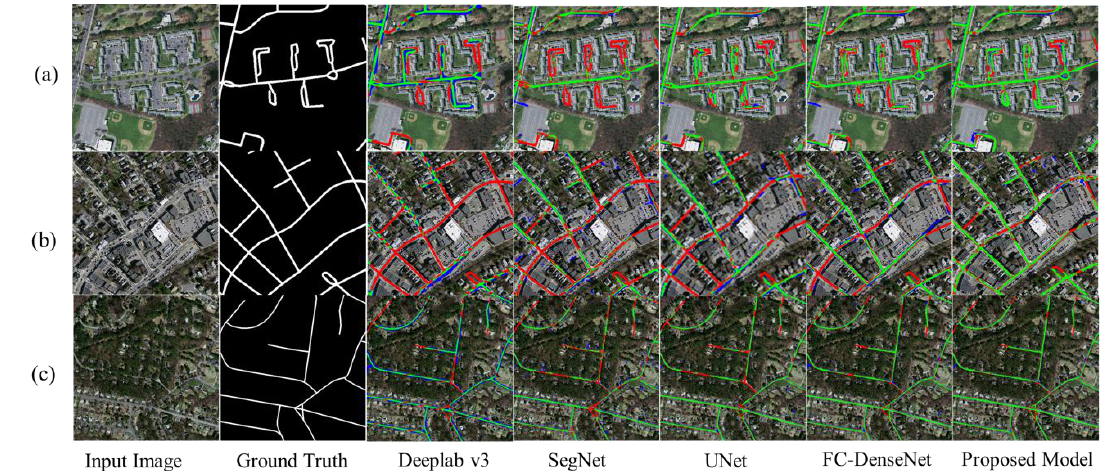
Figure 13. Magnification of the results in Figure 12. True positive (TP) is marked as green, false positive (FP) as blue, and false negative (FN) as red. Each subfigure in this figure is the magnification of the results shown in Figure 12.